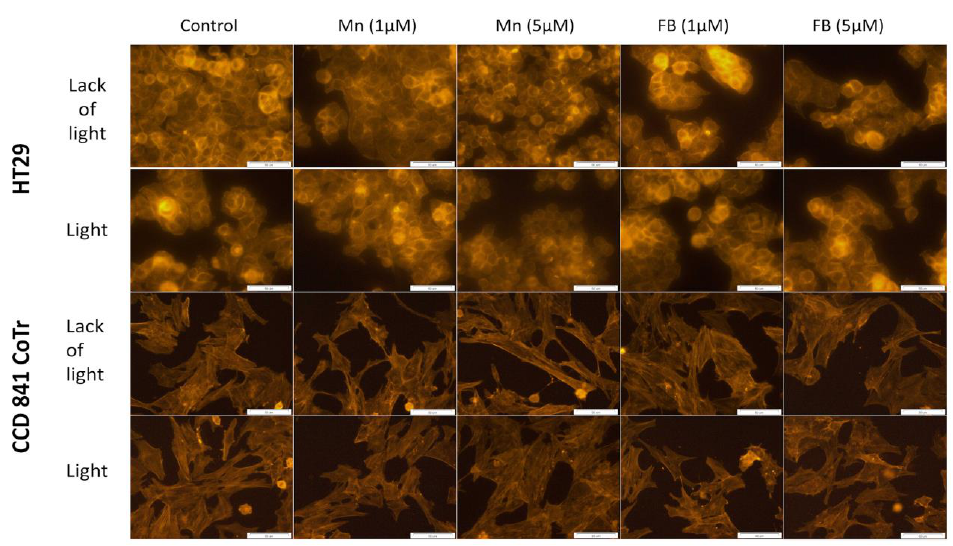
Figure 10. Signal transmission between HT29 cells ( A ) and CCD 841 CoTr cells ( B ). Bar 500 µm.